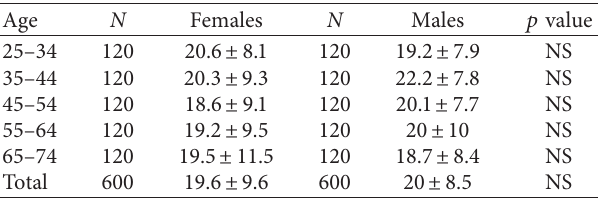
Table 2: Mean and standard deviation (SD) of serum levels of 25- (OH)D (ng/ml) in females and males according to different age groups.